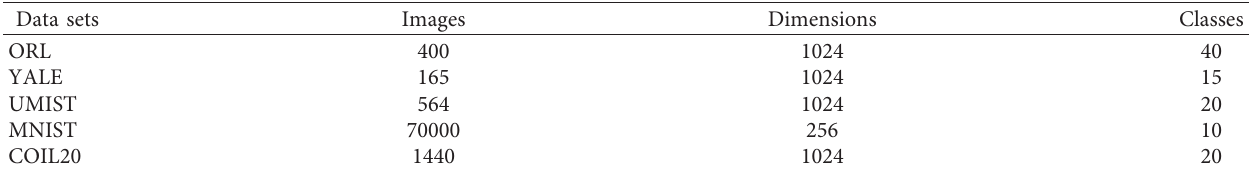
Table 2: Description of benchmark data